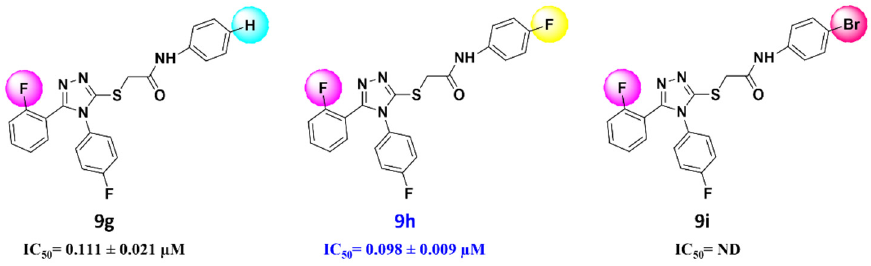
Figure 3. Structural activity relationship of 9g , 9h , and 9i . Table 1. Target compounds and IC 50 values for tyrosinase activity (SEM = standard error of the mean; values are expressed in mean ±